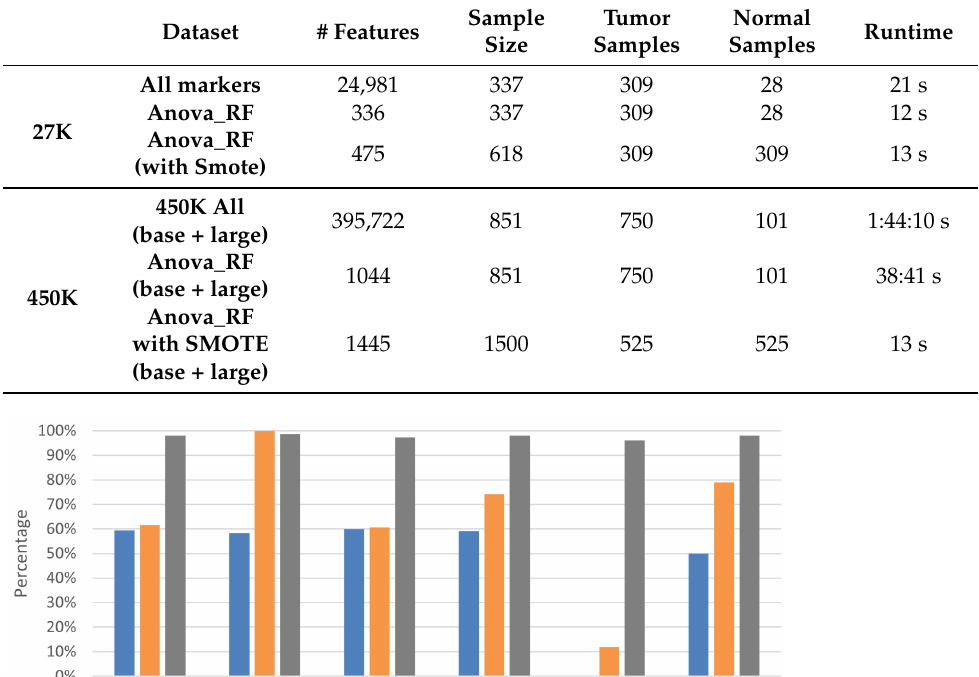
Figure 3. Number of CpG markers selected from ( a ) 27K before SMOTE, ( b ) 27K after SMOTE, ( c ) 450K datasets before SMOTE and ( d ) 450K after SMOTE application. Table 3. Model training set-up for 27K and 450K dataset.